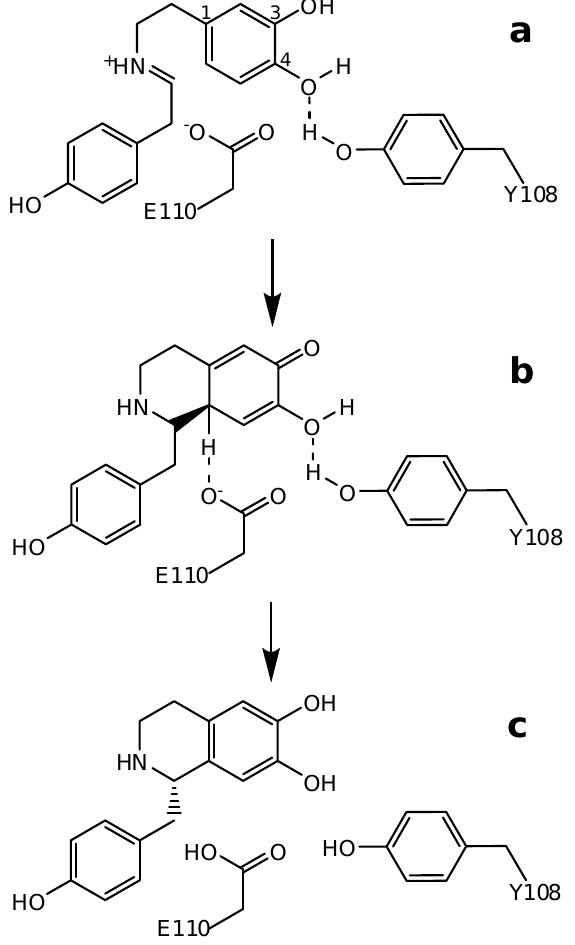
Scheme 3. Mechanism of NCS catalyzed synthesis of